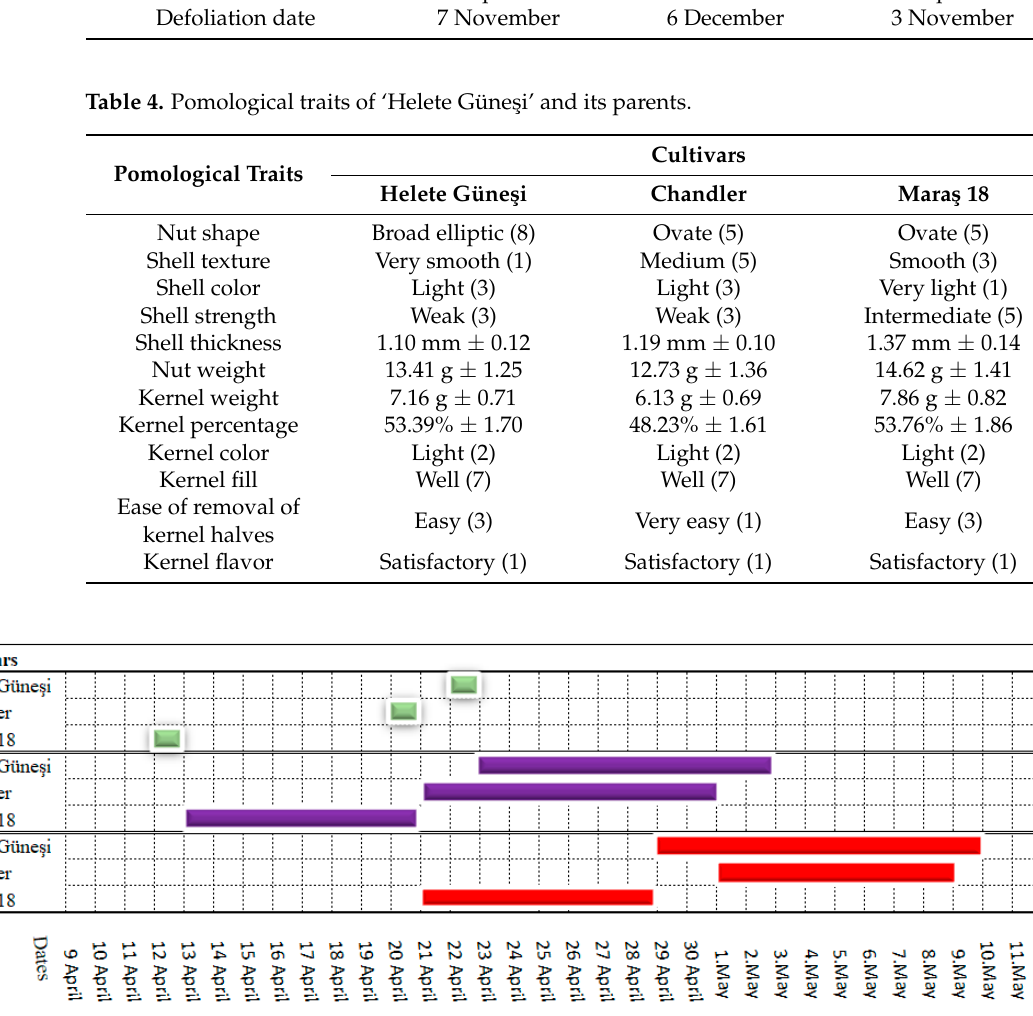
Figure 1. The comparison of some phenological traits in different walnut cultivars.